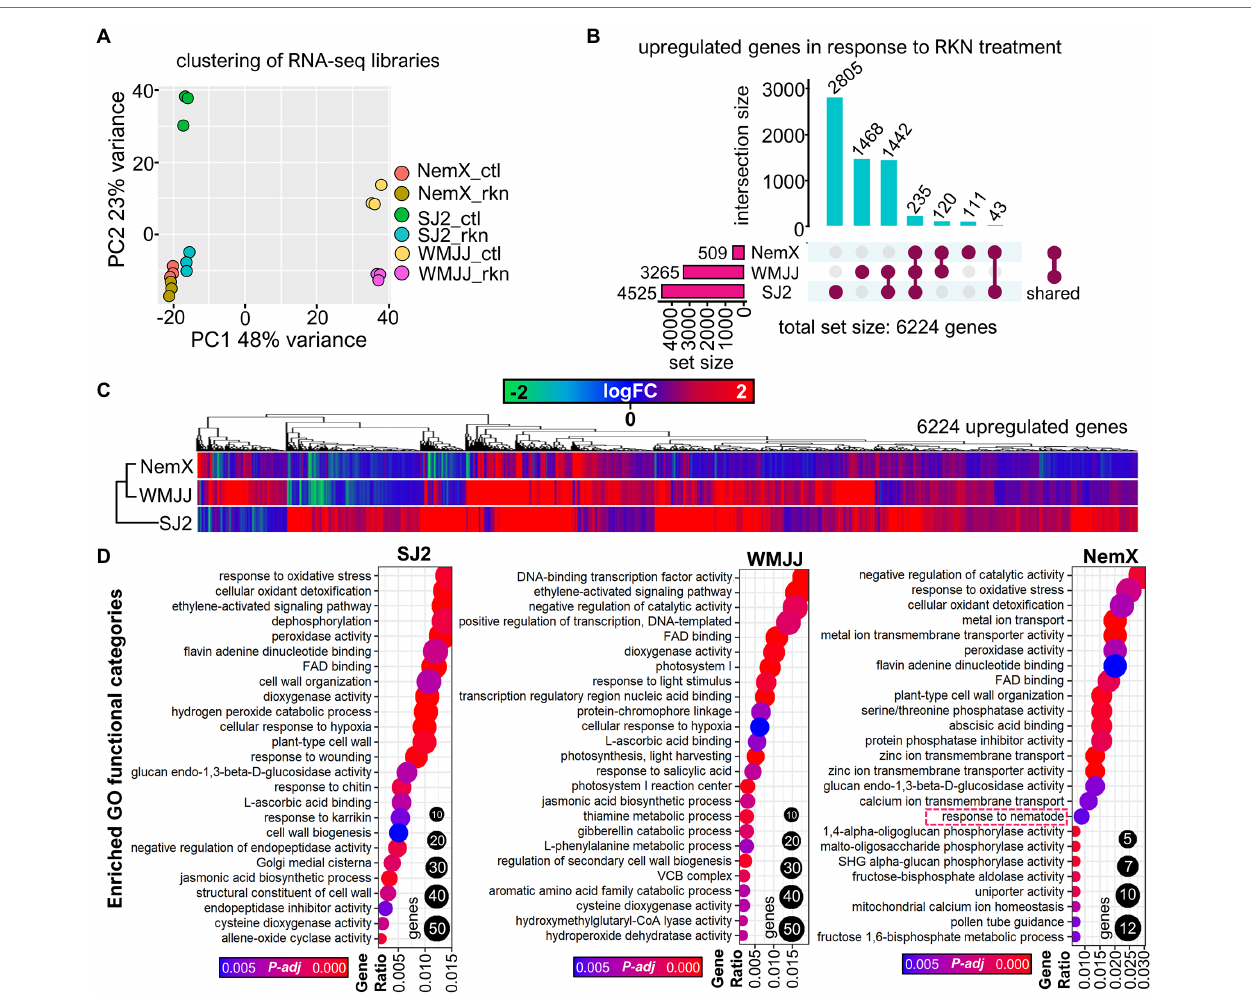
FIGURE 2 | Expression profiling analysis revealed a differential activation of genes and biological processes in response to RKN infection among cotton cultivars SJ2, WMJJ and NemX. (A) PCA analysis of sample relationships for each of the RNA-seq libraries of this study. (B) Venn analysis of upregulated genes in response to RKN-treatment. (C) Heatmap of the upregulation (in logFC units) of the total set of induced genes in SJ2, WMJJ and NemX. (D) Gene Ontology (GO) analysis of significantly enriched functional categories (see Supplementary Material